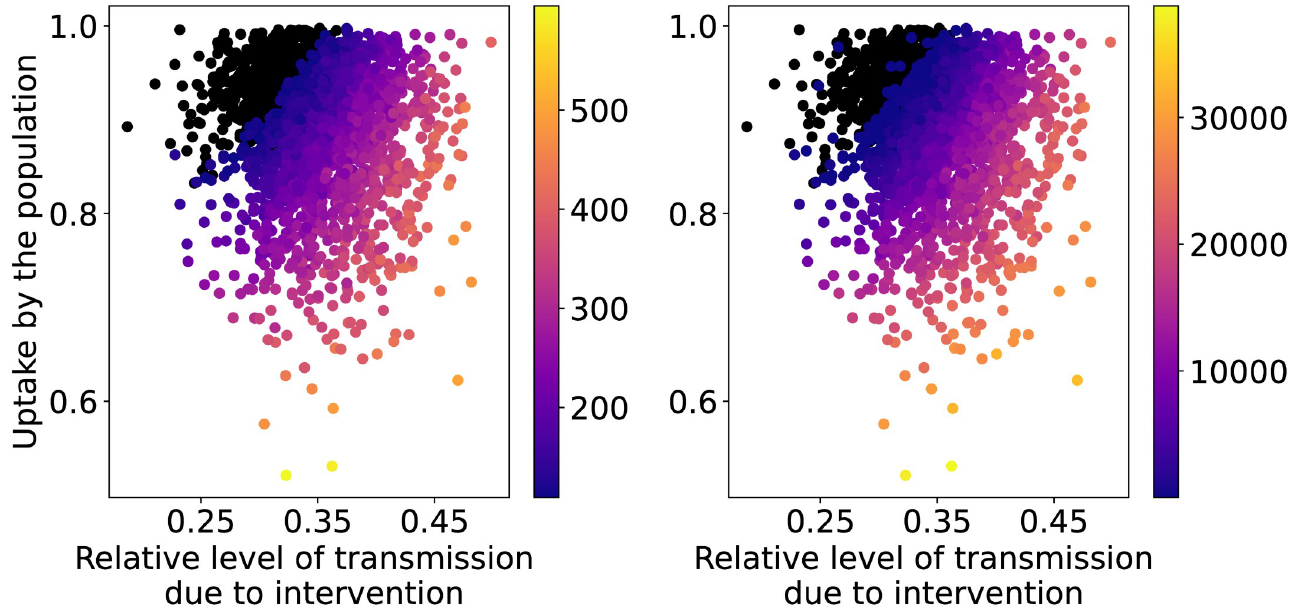
Fig 4. Heat map of the maximum values of patients in IC (left) and the total amount of IC patient-days in excess (right) per million capita as functions of the input parameters for the FC strategy with seed and policy-related uncertainties. The black dots show the simulations whose QoI value is below or equal to the IC capacity or there are no IC patient-days in